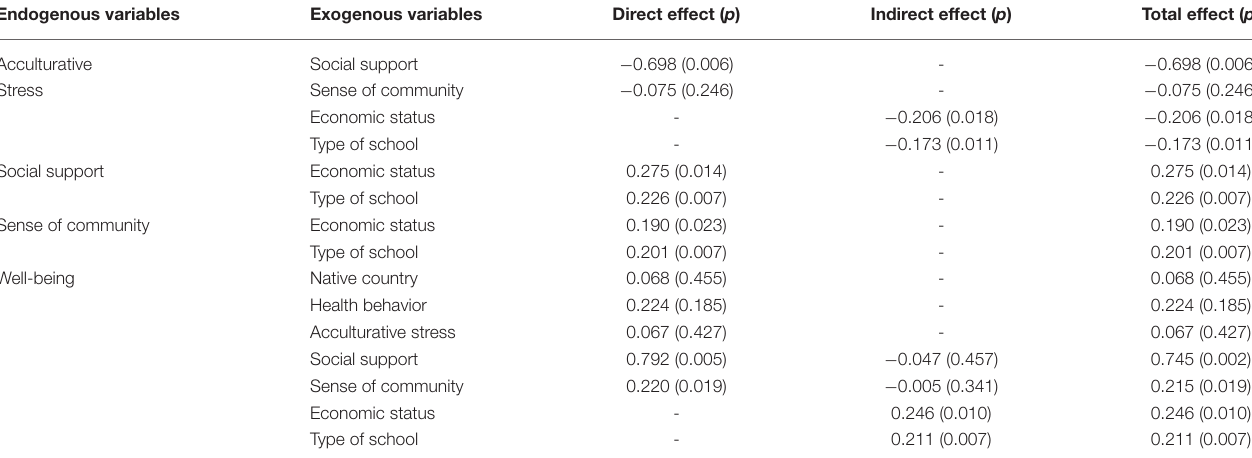
TABLE 3 | Standardized direct, indirect, and total effects for the hypothetical